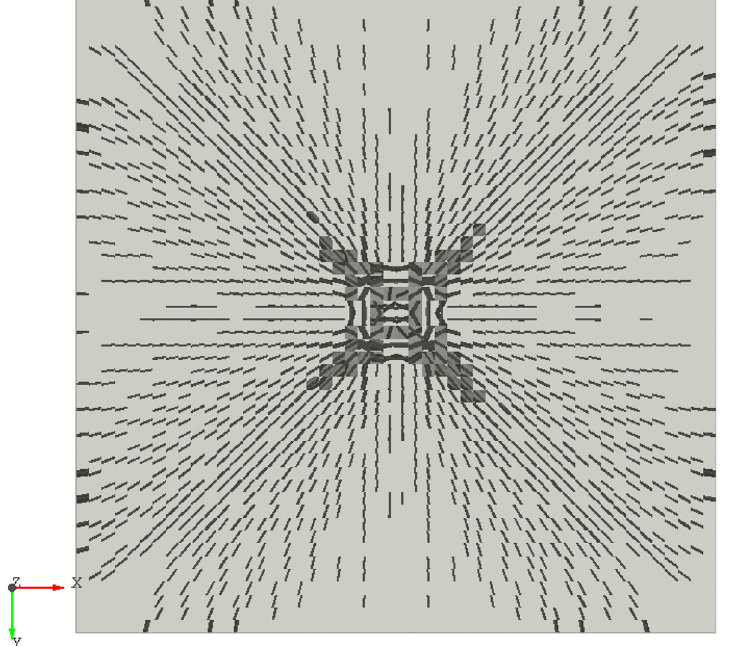
Fig. 14 3D cracked slab: standard values for concrete and E def 33.86